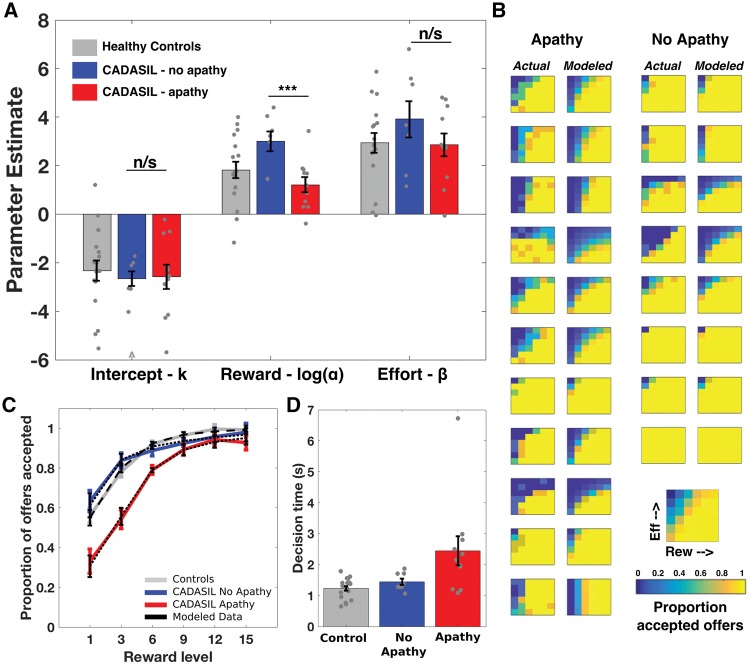

Apathy in CADASIL and reward incentivization. (A) The reward parameter (α) was significantly lower in apathetic compared to non-apathetic patients, whilst neither the effort parameter (β) nor intercept (κ) were significantly different. (B) Actual and modelled choice proportions for each apathetic (left columns) and non-apathetic (right columns) CADASIL patient. (C) Group level choice proportions with increasing reward, with model fits superimposed (black dotted lines). (D) Apathetic patients took longer to make accept/reject decisions than non-apathetic patients or healthy controls. Note that one patient (no apathy) and one control accepted all offers and had outlying (positive) intercepts. For clarity the parameter estimates for these participants are not plotted, however they were included in the analysis (inclusion or exclusion did not change any reported results). ^Outlying value not plotted for clarity (actual value = –18). ***P < 0.01; n/s = not significant.